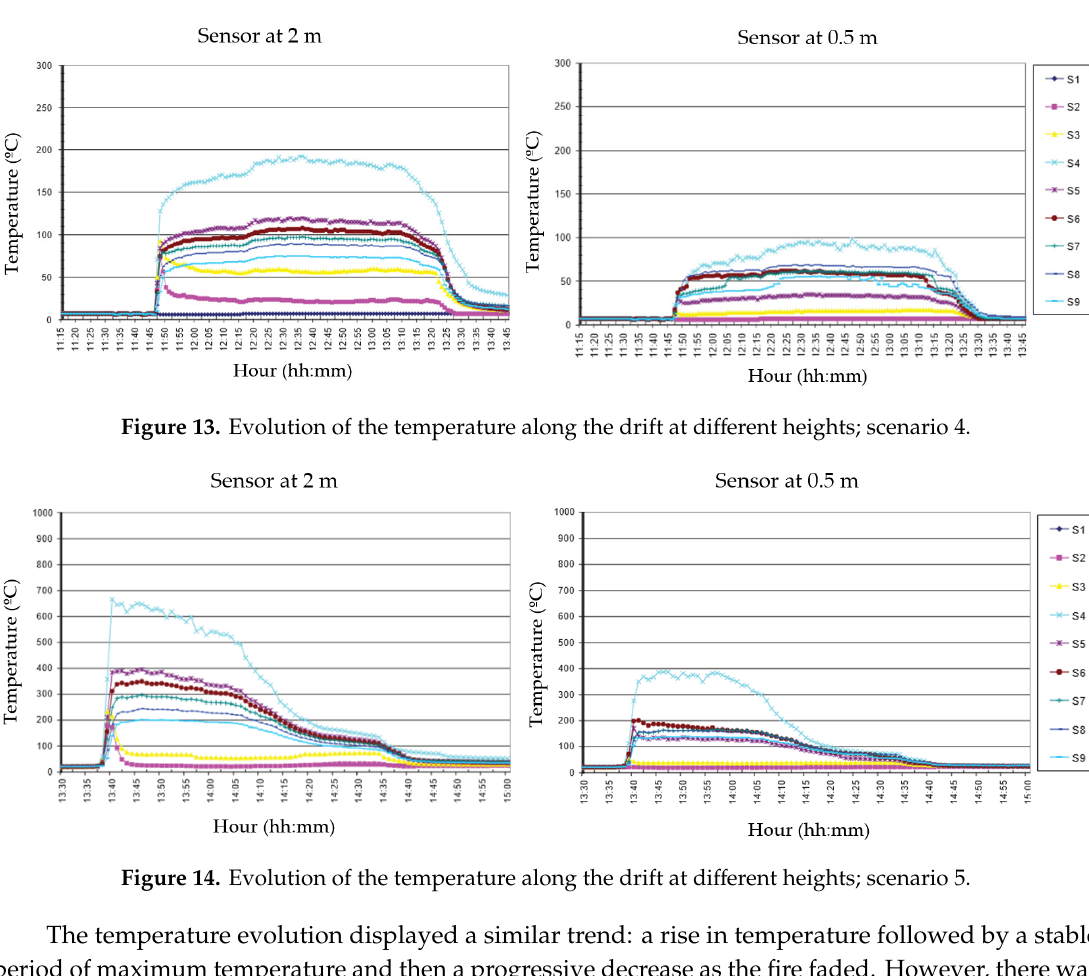
Figure 12. Evolution of the temperature along the drift at different heights; scenario 3.